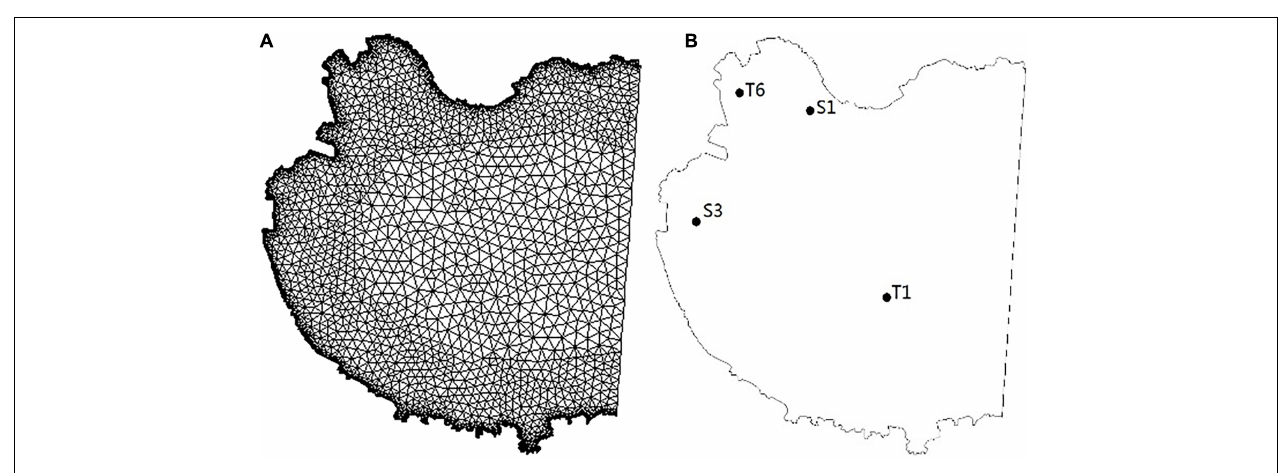
FIGURE 1 | Sketch diagram of the modeling scope of the hydrodynamic model.